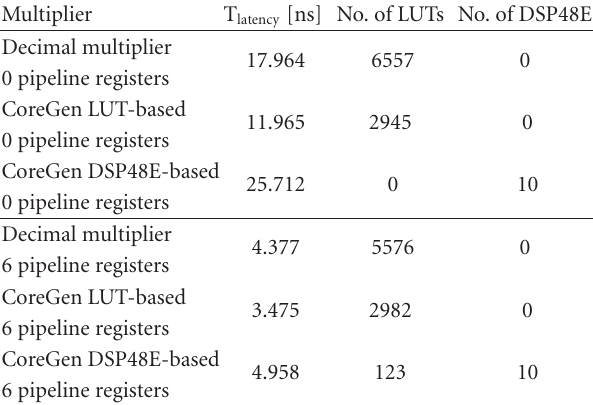
Table 3: Comparison of decimal fixed-point and binary multiplier results.